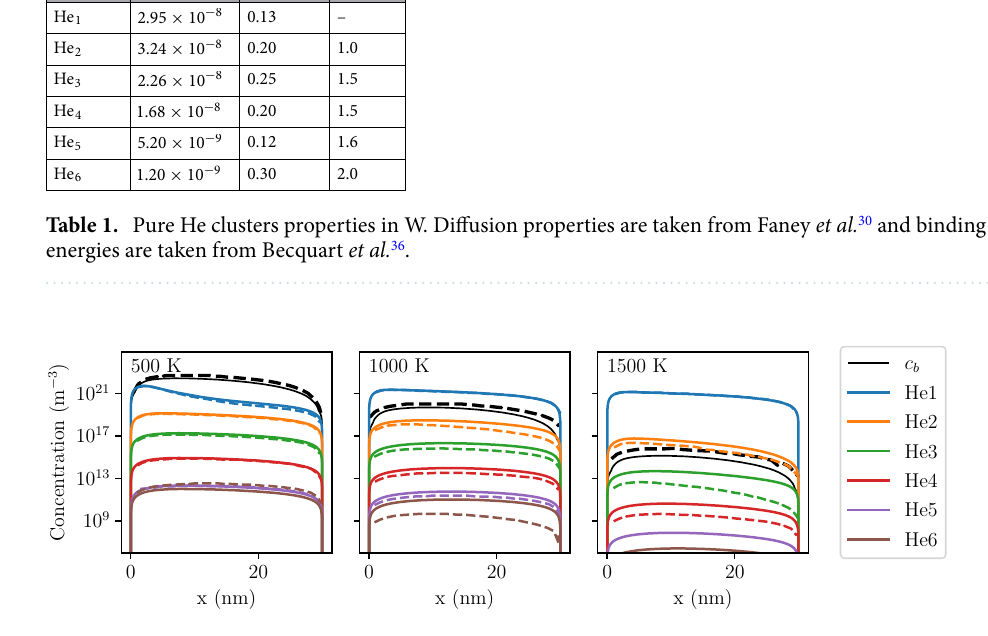
Figure 2. He clusters concentration profiles in the tendril at 500 K, 1000 K and 1500 K. Comparison between the current implementation (solid) and Faney’s results 30 (dashed). Discrepancies at high temperature are likely due to the use of a different set of dissociation energies. At 1000 K and 1500 K the dashed and solid profiles of He 1